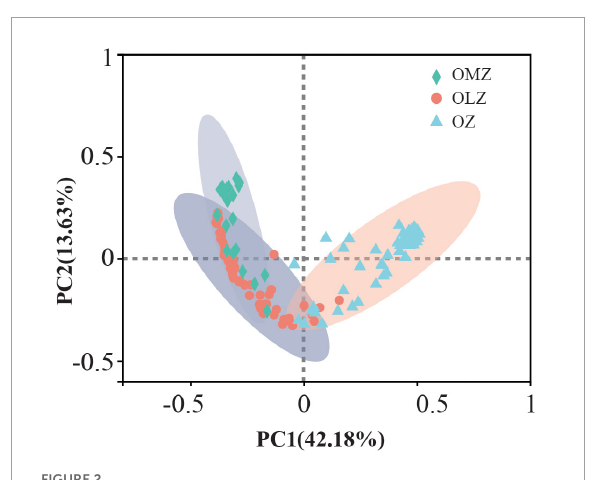
FIGURE2 Principal coordinate analysis (PCoA) of Bray–Curtis distances among communities from the OMZ, OLZ, and OZ waters. ANOSIM was used in the statistical